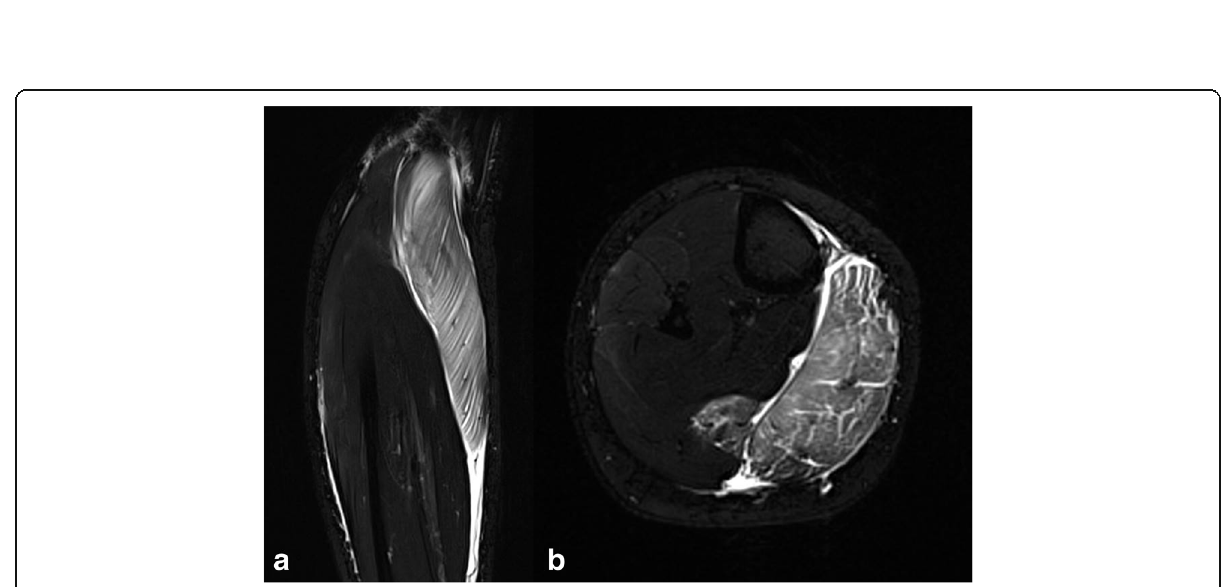
Fig. 2 Indirect ultrastructural muscle injury (Type 1B: Delayed-onset muscle soreness (DOMS)). The MRI demonstrates a widespread intramuscular oedema corresponding to a raise in T2 signal intensity. a : Axial T2-weighted TIRM (Turbo-Inversion Recovery-Magnitude) sequence (total acquisition time, 3:31 min; inversion time, 260 ms; echo time, 69 ms; repetition time, 5120 ms; flip angle, 145°; resolution, 0.8 × 0.8 × 4.0 mm). b : coronal T2-weighted TIRM sequence (total acquisition time, 3:42 min; inversion time, 260 ms; echo time, 68 ms; repetition time, 5120 ms; flip angle, 180°; resolution, 0.9 × 0.9 × 4.0 mm). Published by kind permission of the Department of Radiology, University Hospital